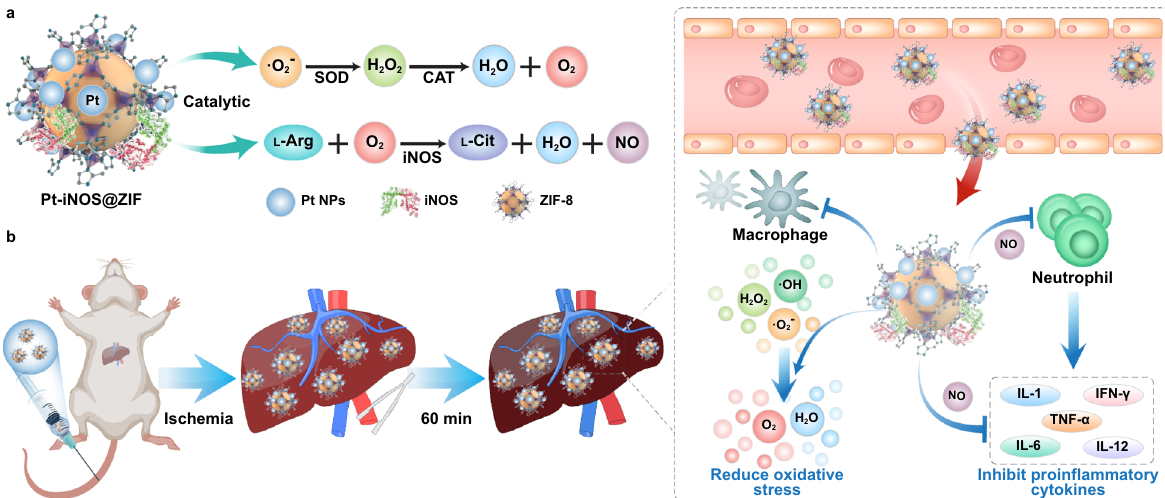
Fig. 1 Schematic illustration of hepatic IRI prevention performance by Pt-iNOS@ZIF nanoreactor. a Illustration of the designed Pt-iNOS@ZIF nanoreactor. The synthesized Pt nanozyme with SOD/CAT-like properties could scavenge overexpressed ROS induced by IRI to generate O 2 . Then iNOS enzyme could further catalyze ʟ -Arginine ( ʟ -Arg) and O 2 . to produce ʟ -Citrulline ( ʟ -Cit) and NO. b Schematic of the hepatic IRI generation and treatment with the Pt-iNOS@ZIF nanoreactor. It can reduce oxidative stress and inhibit proin fl ammatory cytokines, resulting in effective prevention the liver from